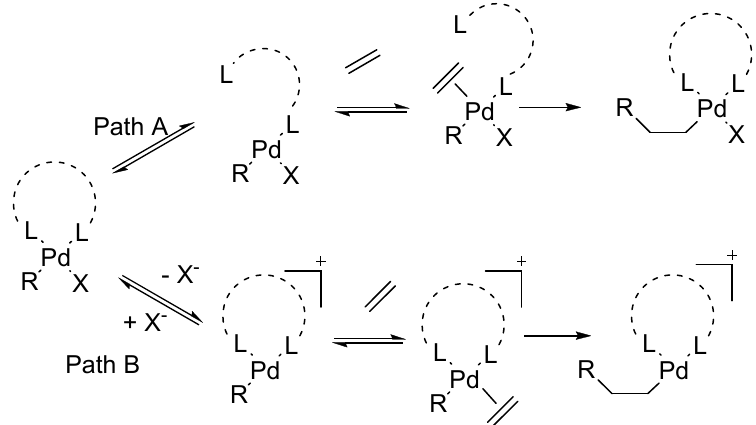
Scheme 6. Olefin substituents via coordination ‐ insertion